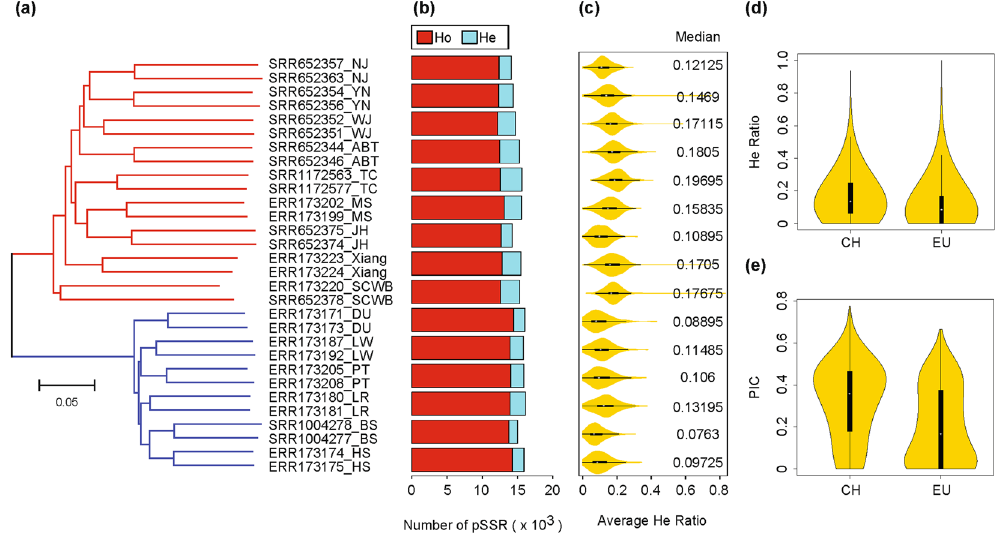
Figure 6. Validation of high-quality pSSRs in population genetics. ( a ) Neighbour-joining phylogenetic tree constructed from 30 samples based on all high-quality pSSRs. The red and blue branches represent Chinese and European breeds, respectively. The scale bar represents the pairwise distance. NJ, Neijiang; YN, Yanan; WJ, Wujin; ABT, Aba Tibetan; TC, Tongcheng; MS, Meishan; JH, Jinhua; SCWB, southern Chinese wild boar; DU, Duroc; LW, Large White; PT, Pietrain; LR, Landrace; BS, Berkshire; HS, Hampshire. ( b ) Average number of homozygous and heterozygous SSRs of two individuals in each breed. ( c ) Average heterozygous ratio of each breed in 10 Mb-length non-overlapping sliding windows. ( d ) Heterozygous ratio and ( e ) PIC of each high- quality pSSR in the “CH” and “EU” subpopulations. The “CH” subpopulation contains all Chinese breeds except for SCWB, and all 14 European breeds are in the “EU”